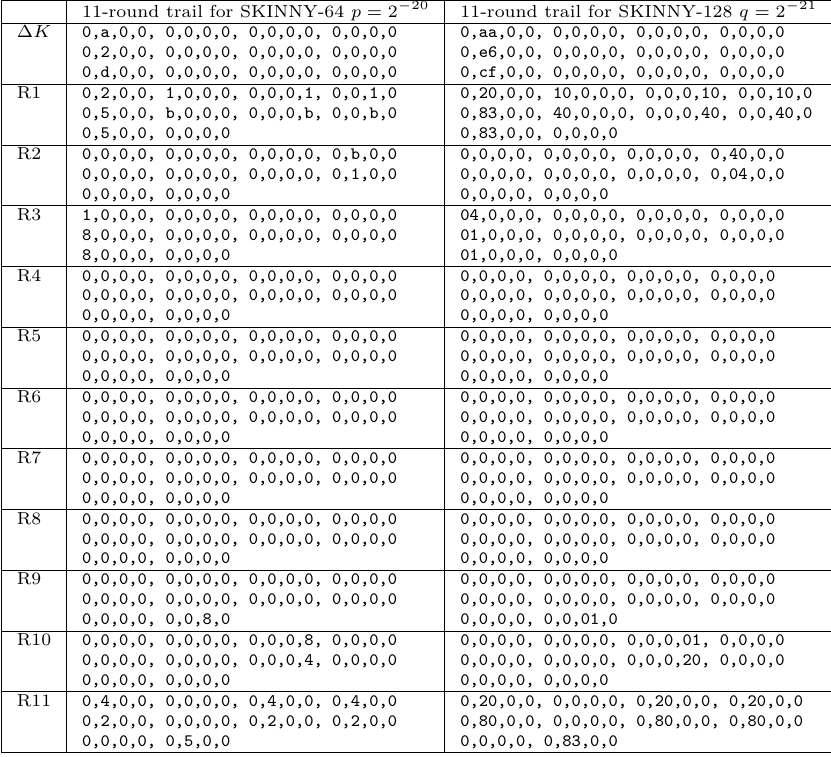
Table 14: Trails for SKINNY under TK3 11-round trail for SKINNY-64 p = 2 − 20 11-round trail for SKINNY-128 q = 2 − 21 ∆